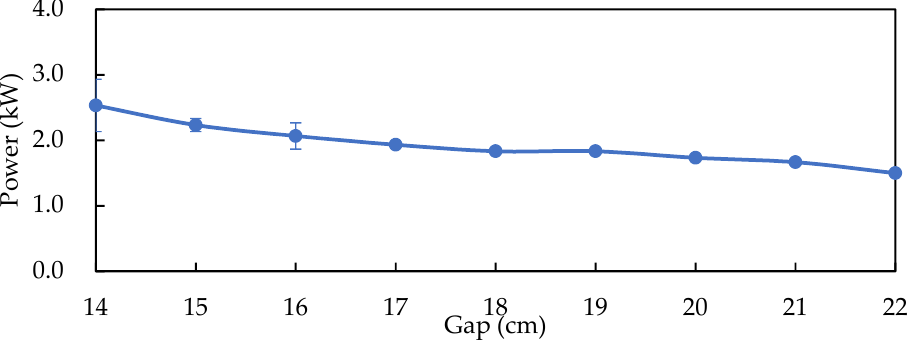
Figure 1. RF power output for different electrode gaps of 500 g solid-state fermented W. cocos product. Data are expressed as the mean ± SD ( n = 3).